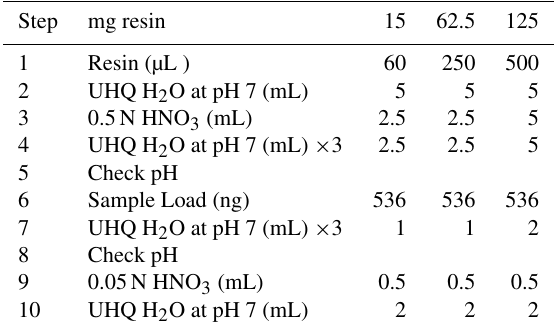
Table 1. Protocol used to evaluate the column chemistry method of boron extraction. Three volumes of resin (60, 250, and 500µL) were